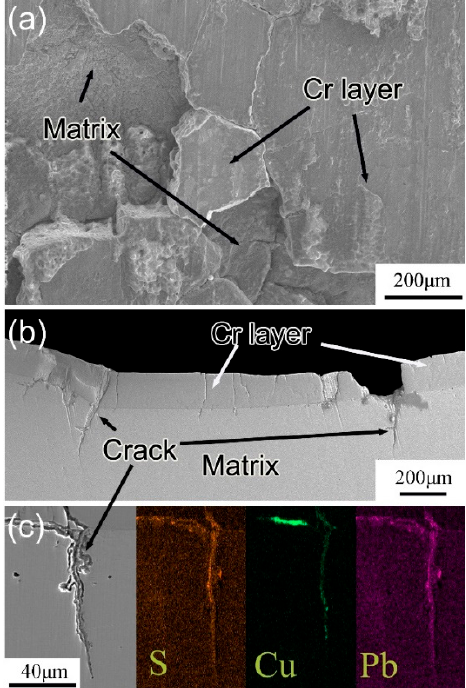
Figure 6. SEM morphologies of MG3: ( a ) bore surface; ( b ) cracks in cross-section; and ( c ) EDS energy spectrum of a crack.